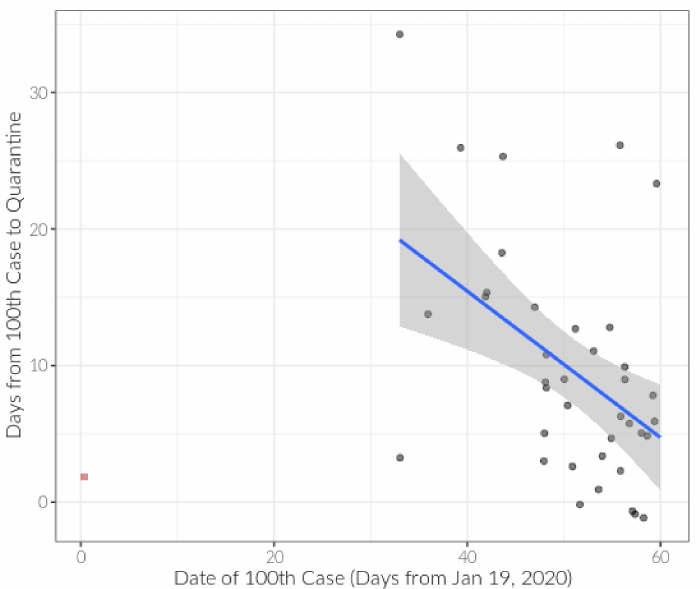
Figure 2. Days from 100th case to quarantine plotted against date of 100th case (in days from 19 January 2020; China’s 100th case). The two variables are correlated (r = − 0.47, p = 0.003) after removing China (red